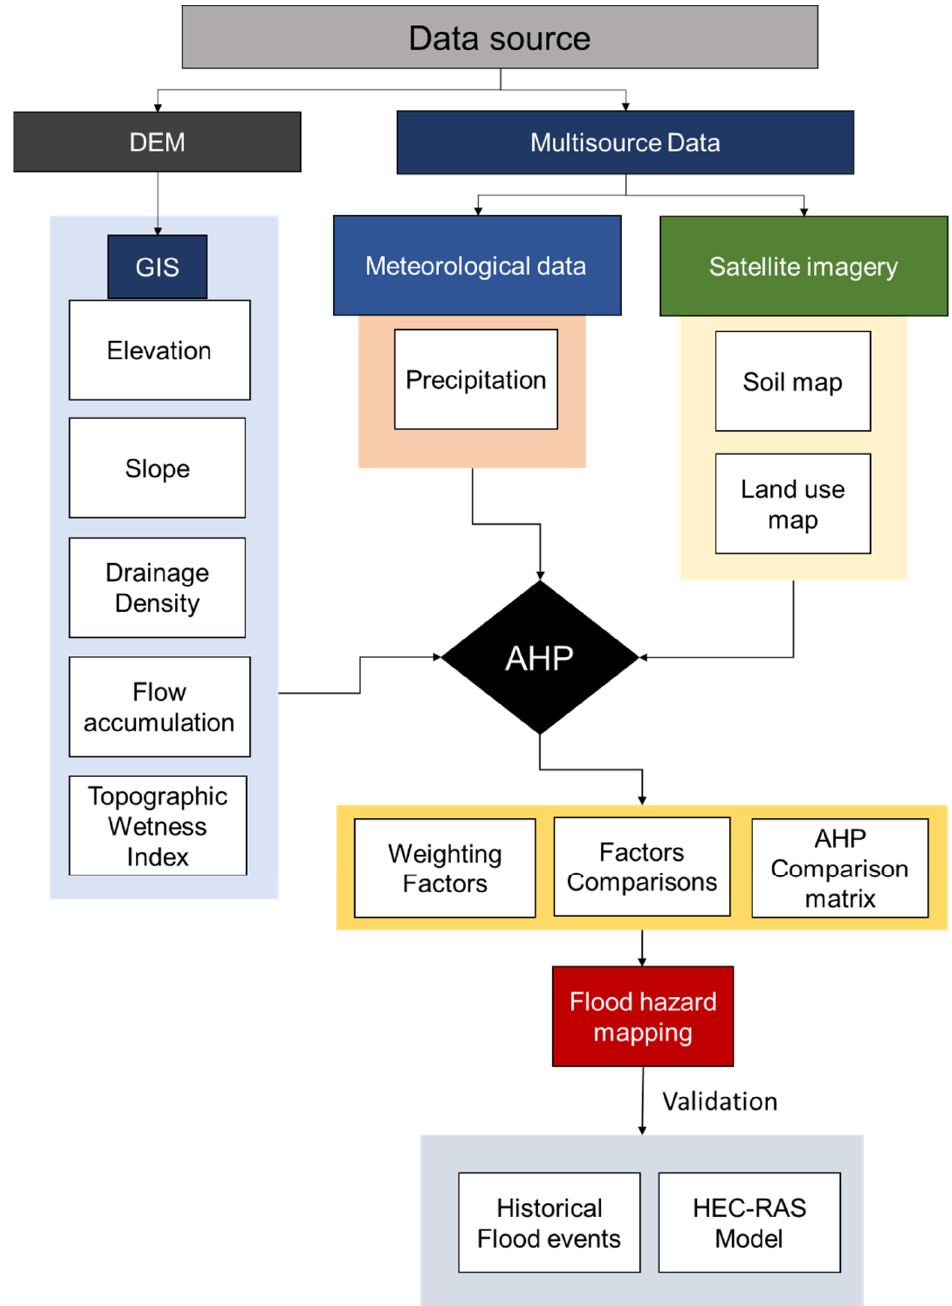
Figure 4. Flow chart of the methodology in the present study.